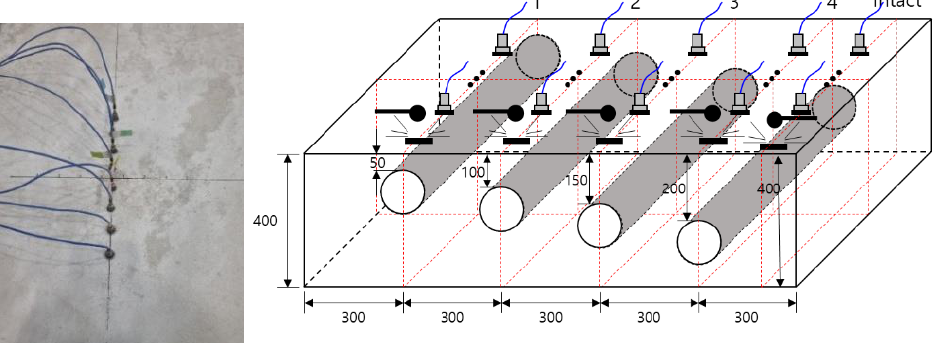
Figure 4. Test setup and procedure for measuring elastic waves with IE test (dimensions in mm). IE has been studied for various types of defects, and its characteristics are shown in Figure 5. In Figure 5a, the estimation of the thickness mode frequency ( ft ) for concrete without internal defects is the same as in Equation (1) [11] (p. 2). If there are voids and cracks with 1/4 < a/d < 1/3 inside, ft is shifted to a lower frequency. Here, β is the correction factor, C P is the p -wave speed, and T is the slab thickness.